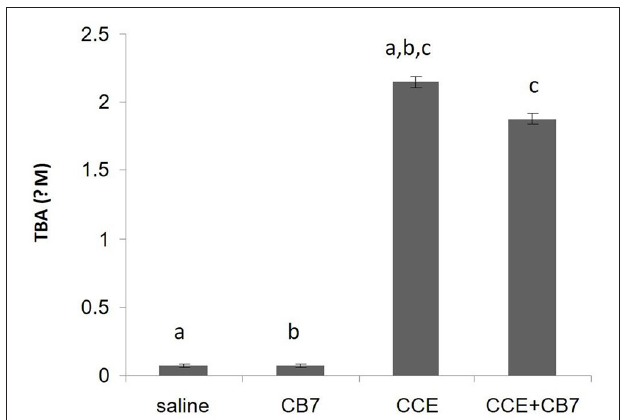
FIGURE 4 | Levels of thiobarbituric acid (TBA), which is indicative of lipid peroxidation, calculated from the livers of mice in each group. Data are presented as mean ± SEM. Bars with similar letters represent statistically significant differences. Ten mice per group ( n = 10).